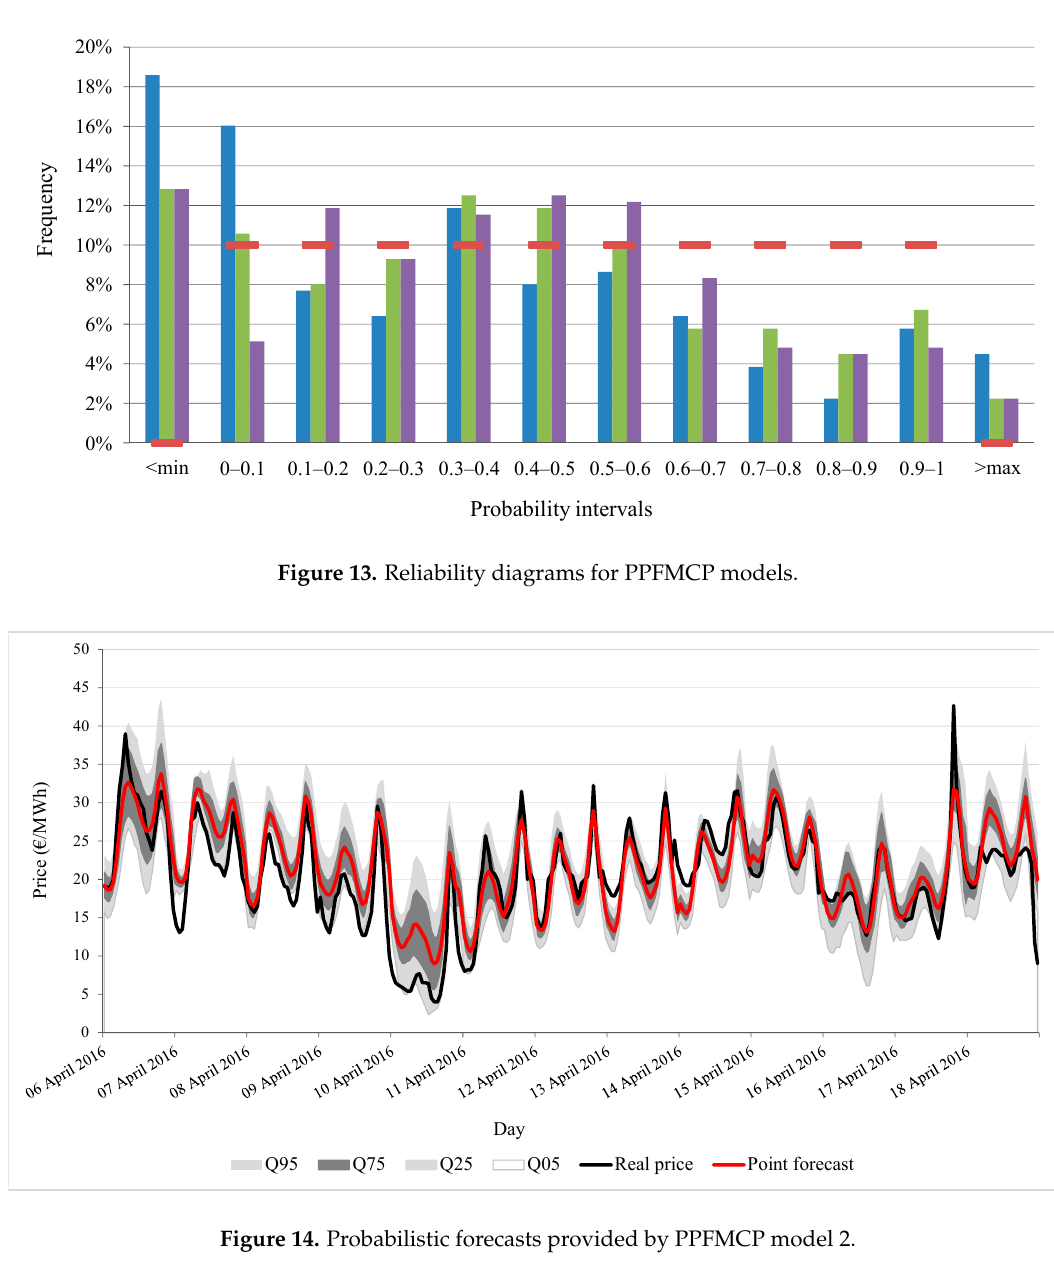
Figure 14. Probabilistic forecasts provided by PPFMCP model 2.